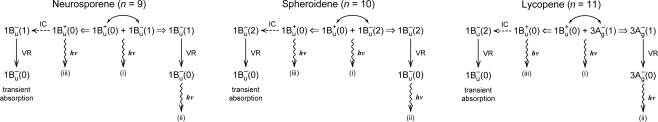
Schemes of relaxation processes when the set of Cars (n = 9–11) is coherently excited with ∼30 fs pulses to the 1Bu+(0) + X−(υ) diabatic pairs (for the notation of X−(υ), see the caption of Figure 19): The initial set of stimulated emissions can be explained in terms of quantum beat. In Car (n = 10), for example, it consists of (i) the persistent stimulated emission from the 1Bu+(0) + 1Bu−(2) diabatic pair as the coherent cross term, (ii) the short-lived 1Bu+(0) stimulated emission as one of the split incoherent terms and (iii) the short-lived 1Bu−(0) stimulated emission as the other split incoherent term. Also, the 1Bu+(0) species internally-converts to 1Bu−(2) and, then, vibrationally-relaxes to the 1Bu−(0) species, which gives rise to transient absorption. In Car (n = 11), 1Bu−(2) is replaced by 3Ag−(1) in (i) and (iii).